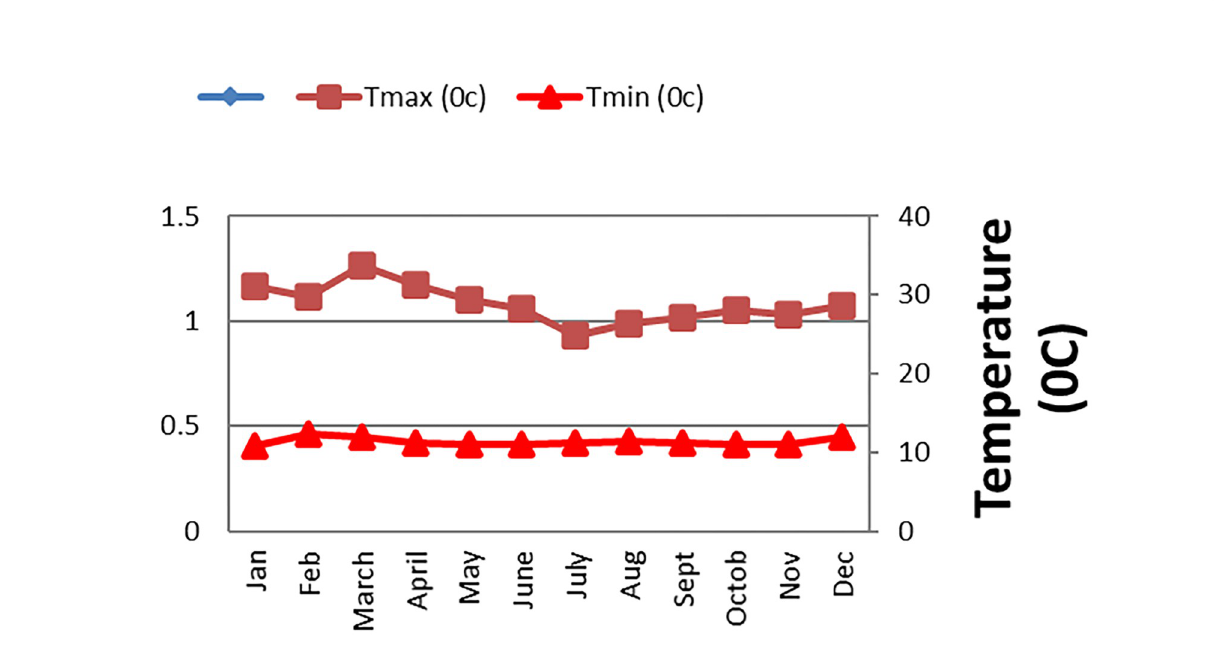
PLOS ONE | https://doi.org/10.1371/journal.pone.0272924 September 15,